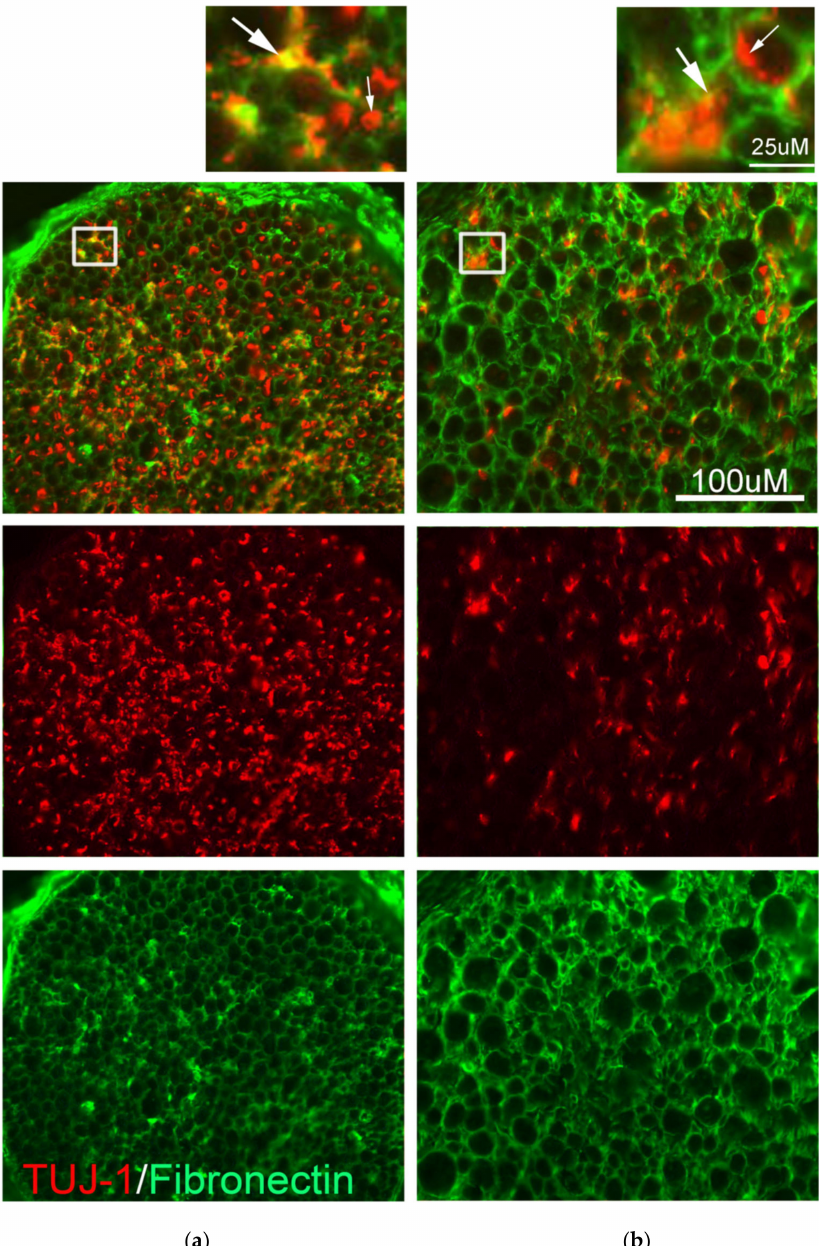
Figure 2. TUJ-1/fibronectin for axonal outgrowth. Representative figure of 3 experiments. Cross- sections were collected from the mid-way of the grafted nerves (marked A in the diagram from Figure